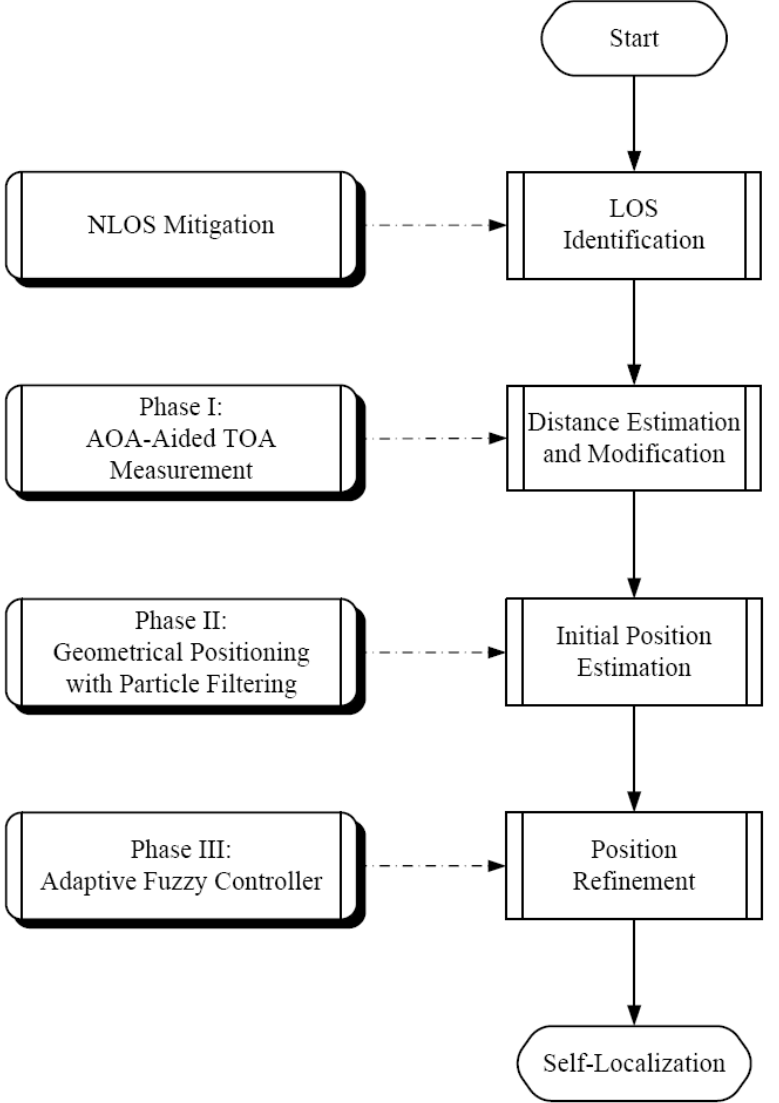
Figure 1. Illustration of block diagram for the ATPA